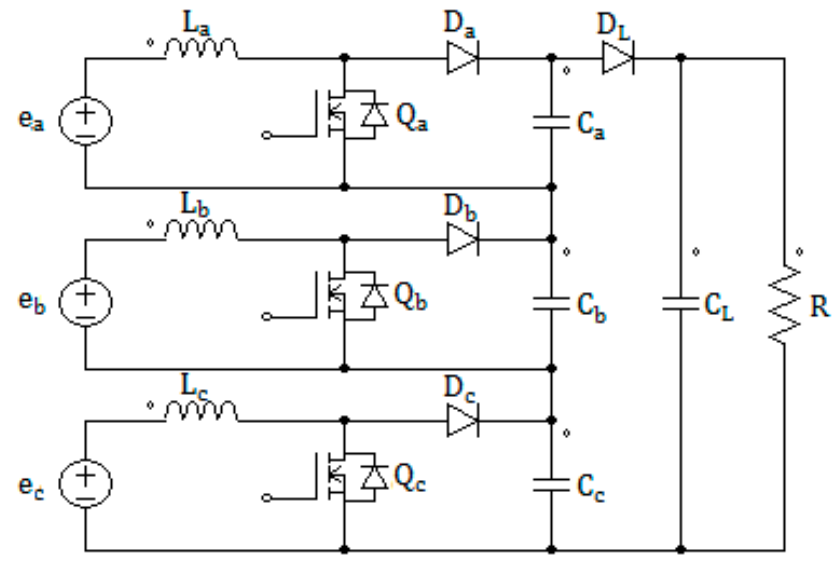
Figure 8. Series-connected boost converters [30,31].